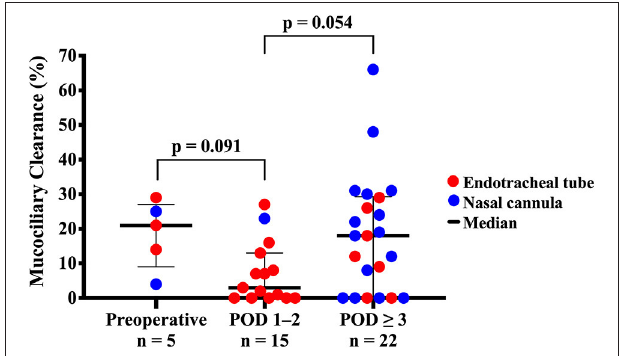
FIGURE 2 | Pre-operative and post-operative mucociliary clearance in infants with congenital heart defects. Infants with congenital heart disease undergoing congenital cardiac surgery had mucociliary clearance measured in one of three different perioperative time points: pre-operative, immediate post-operative (post-operative days 1–2) or later post-operative ( ≥ 3 post-operative days). Red dots refer to scans performed via endotracheal tube for intubated infants, and blue dots are scans performed via nasal cannula for non-intubated infants.